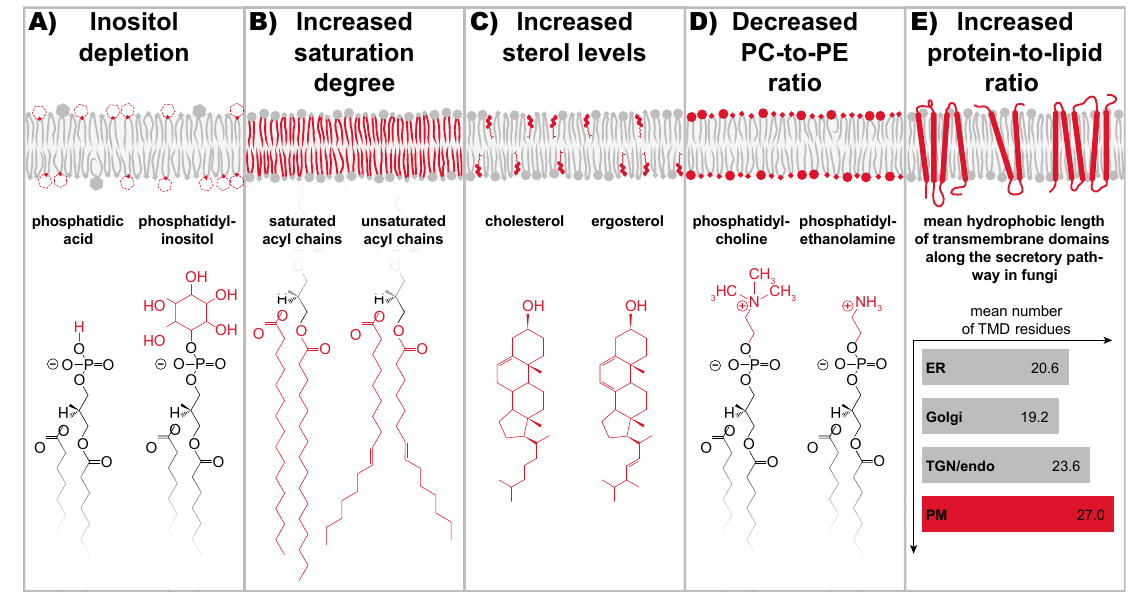
Figure 3. Overview of conditions causing lipid bilayer stress (LBS). Various perturbations of lipid metabolism cause LBS and provide potent signals for UPR activation. ( A ) The depletion of inositol reduces the level of phosphatidylinositol (PI) lipids and causes a robust, but transient activation of the UPR via a membrane-based mechanism. ( B ) An increased level of tightly packing lipids with two saturated fatty acyl chains stiffens the ER membrane and activates the UPR. ( C ) Increased sterol levels in the ER cause ER membrane stiffening and UPR activation. ( D ) A decreased PC-to-PE ratio directly activates the UPR by an unknown mechanism. An increased PC-to-PE level has also been associated with chronic ER stress, but seems to act indirectly via an impact on protein folding. ( E ) The accumulation of plasma membrane proteins with thick, hydrophobic transmembrane domains in the ER, causes a stretching of the fatty acyl chains in ER membrane lipids. We have proposed that an overcrowding of the ER with membrane proteins of the late secretory pathway, exhibiting a higher average number of hydrophobic transmembrane residues, causes LBS and UPR activation [136].